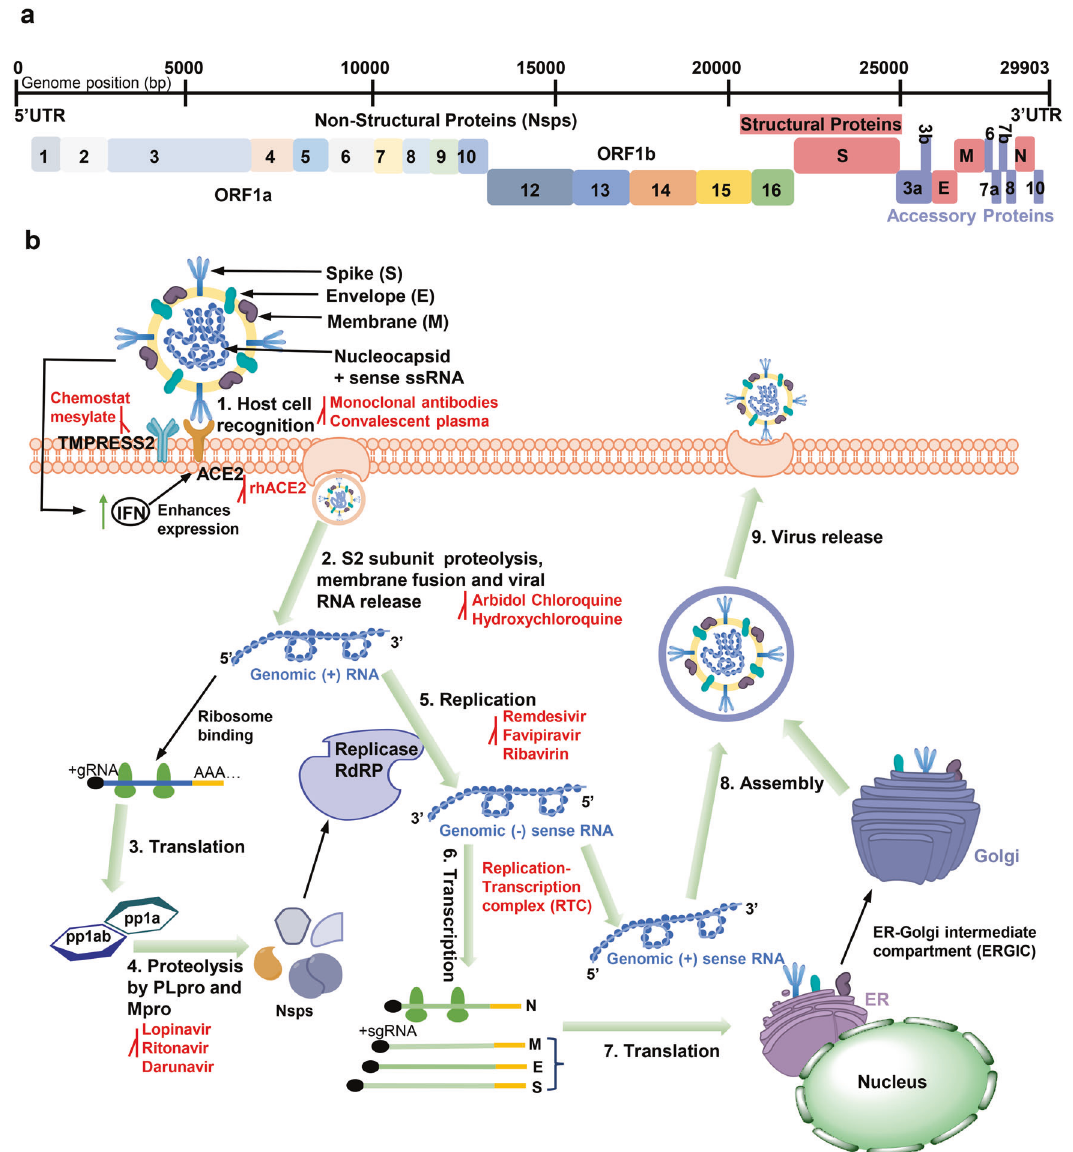
Fig. 1 The whole-genome composition and replication cycle of SARS-CoV-2 and potential targets. a The viral genome encodes 16 nonstructural proteins (Nsps) required for replication/transcription and structural proteins required for the assembly of new virions. b the SARS-CoV-2 mainly infects lymphatic epithelial cells and type II pneumocytes with the initiation of human body ’ s innate response by producing interferons (IFNs). However, IFN activates expression of ACE2 protein which acts as receptor for virus attachment to host cells. Interaction between S protein and ACE2 leads to proteolytic cleavage at the S1 – S2 boundary and S2 ʹ site mediated by transmembrane protease serine 2 (TMPRSS2), further inducing the viral and host cell plasma membrane fusion. The single-stranded RNA in the viral genome is translated by host machinery to produce viral polypeptides (pp1a and pp1ab), which undergo proteolytic cleavage by PLpro and Mpro proteins to synthesize Nsps. These Nsps encode replication transcription complex (RTC), which continuously replicates and produces a series of subgenomic messenger RNAs that encode the accessory and structural proteins. The viral genomic RNA and proteins are assembled to form the virus particles in the ER-Golgi intermediate compartment (ERGIC). The vesicle-containing virus then fuses with plasma membrane of the host, releasing the viral particles out of the cell The antiviral molecules with target sites are highlighted in red